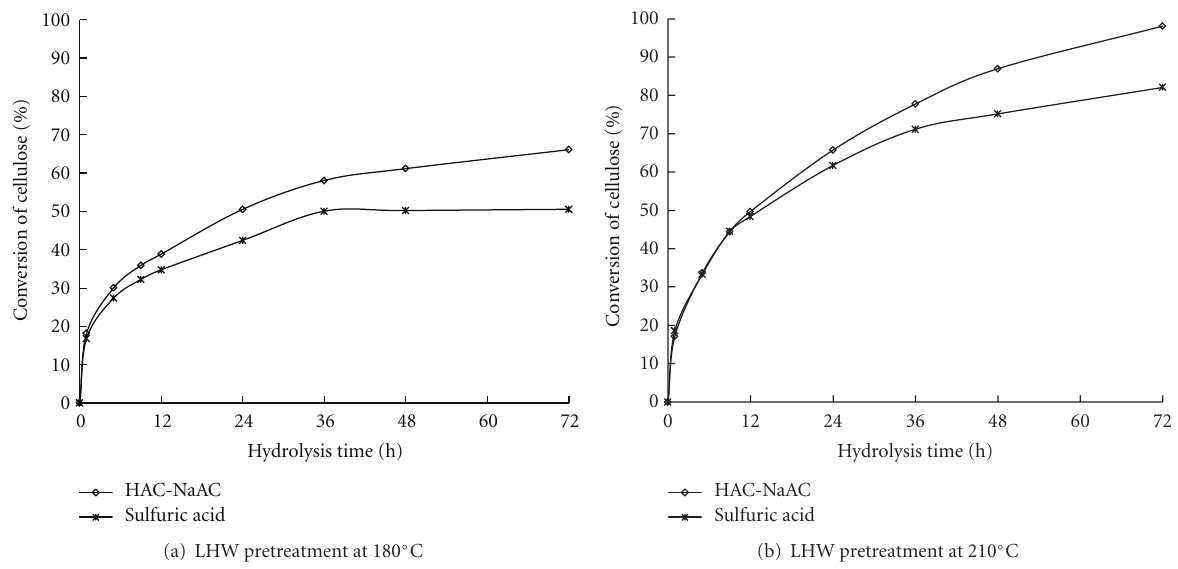
Figure 3: Enzymatic hydrolysis of WIS from LWH-pretreated reed at 180 ◦ C and 210 ◦ C by using two types of pH adjustment in the hydrolysis system. ∗ Enzymatic hydrolysis: 30FPU/g oven-dried WIS at 36 ◦ C.